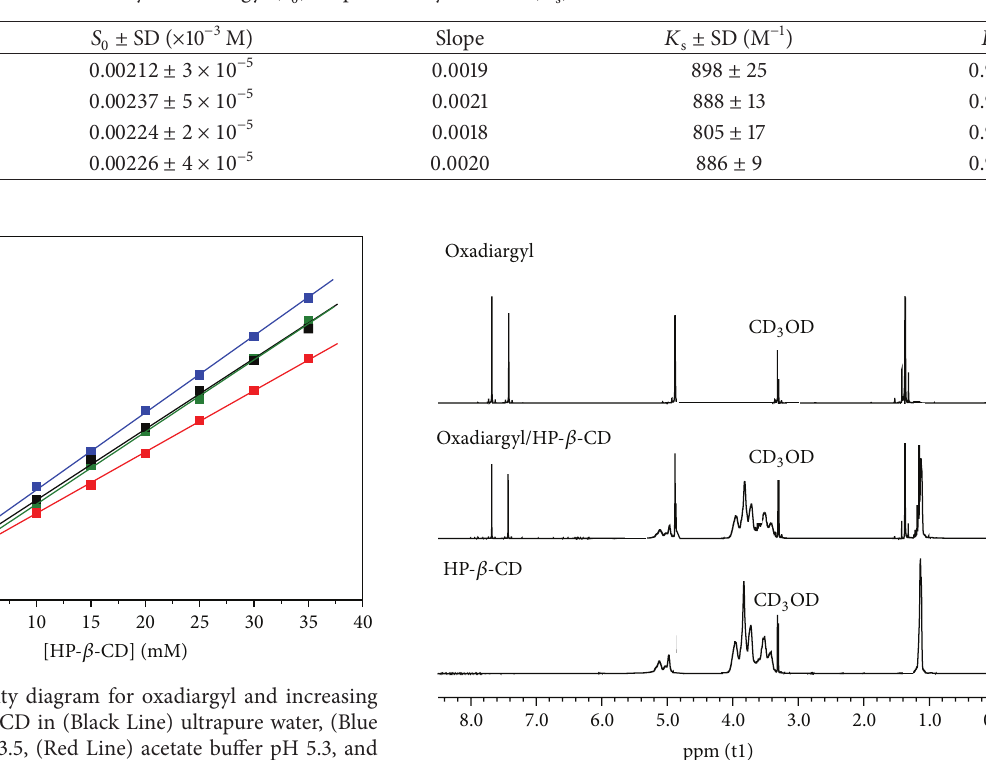
Table 1: Solubility of oxadiargyl ( 𝑆 0 ), slope, stability constant ( 𝐾